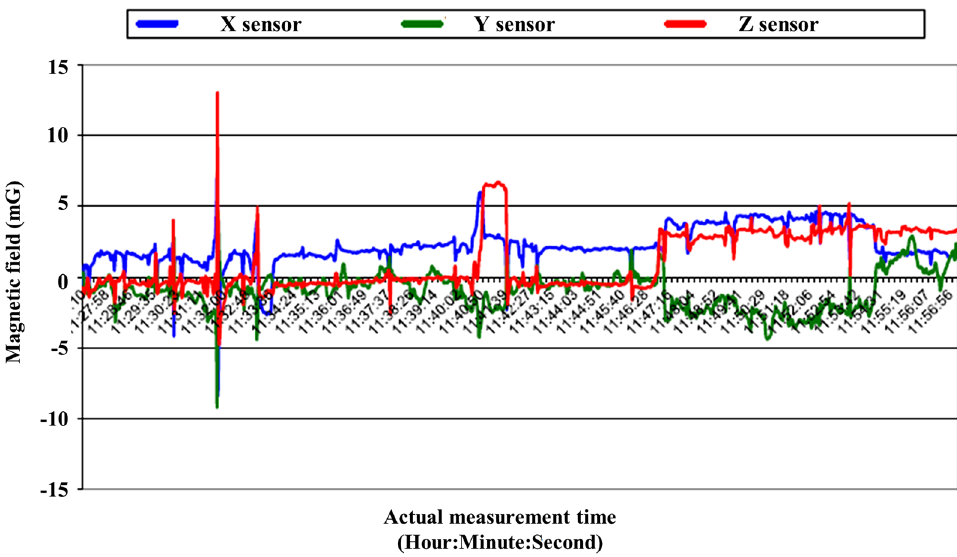
Figure 3. DC magnetic field measurement for 30 min.